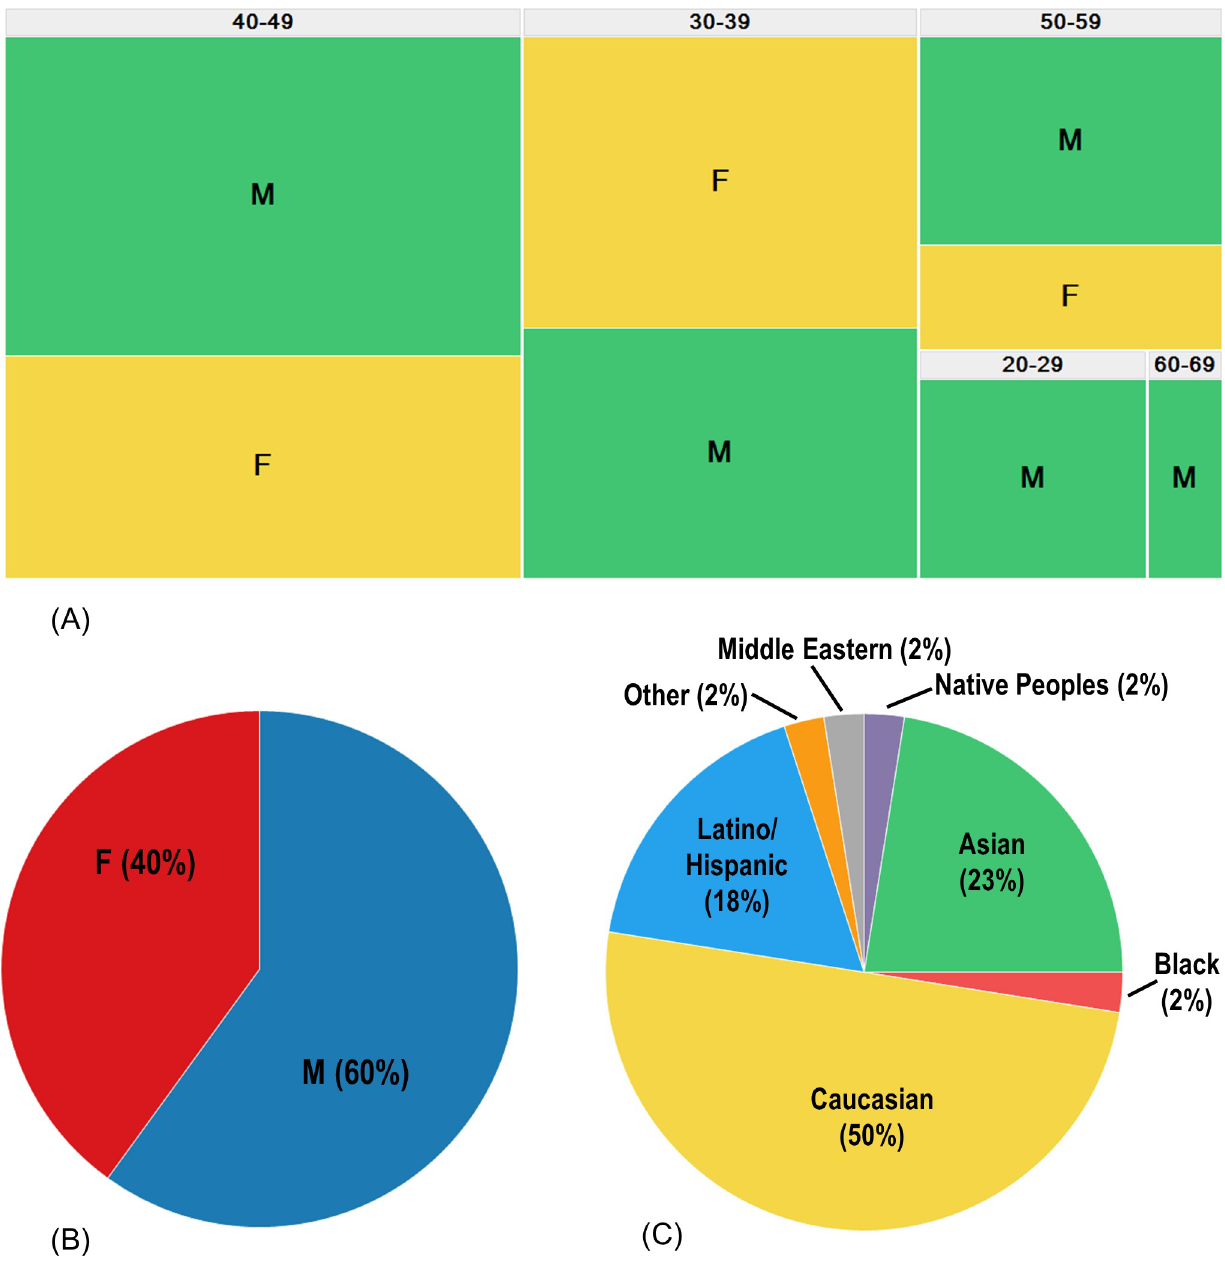
Fig 1. Summary of the demographics of study volunteers. Healthy volunteers (N = 40) were enrolled in this study, donating 6 serum samples over 10-week period or less. (A) Overall age and gender metrics for this cohort, where the area of each rectangle is proportional to the number of volunteers that segregate into each age group. (B) Overall gender split: the cohort consisted of 16 females and 24 Males. (C) Summary of the individually-identified ethnic demographics for the volunteer